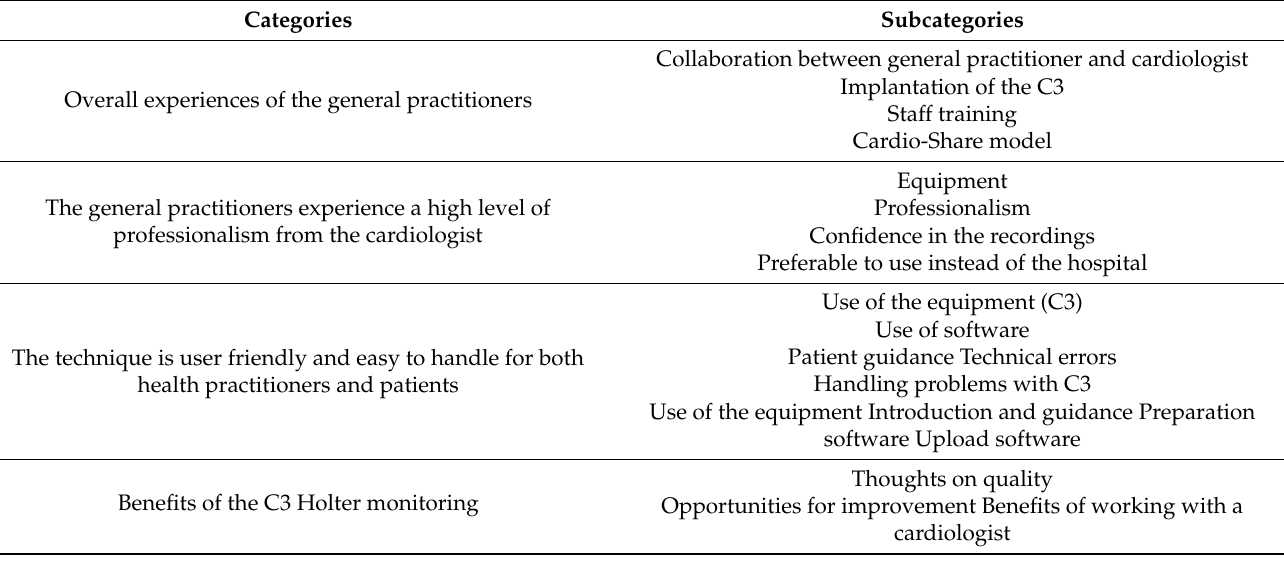
Table 2. Categories and subcategories of GPs’ experiences of the Cardio-Share